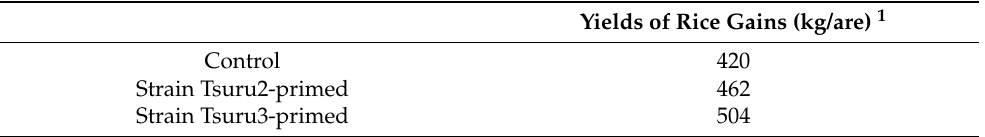
Table 1. Yields of rice gains from the control, strain Tsuru2-primed and strain Tsuru3-primed paddy field.